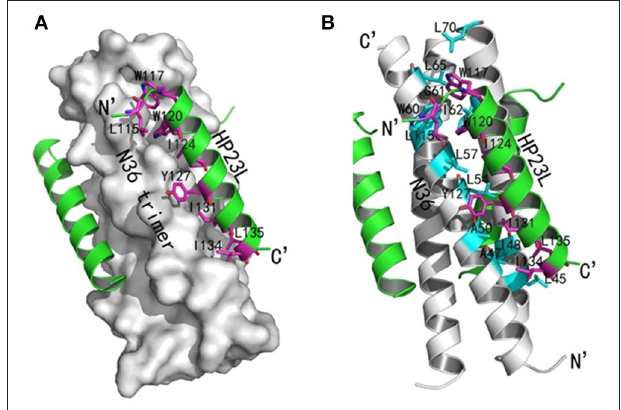
FIGURE 3 | Hydrophobic interactions in 6-HB structure of HP23L/N36. (A) The crystal structure of HP23L/N36 is presented in ribbon and surface models vertically by PyMOL. The N36 trimer is shown as surface model and colored in gray. The HP23L inhibitors are shown as ribbon models and colored in green. Residues related to hydrophobic interactions with N36 trimer on HP23L are shown as stick models in pink. The N- and C-termini of HP23L are labeled. (B) The crystal structure of HP23L/N36 is presented in ribbon models vertically by PyMOL. The N36 trimer is shown in gray. Residues related to hydrophobic interactions on N36 trimer are shown as stick models and colored in cyan. HP23L inhibitors are colored in green. Residues related to hydrophobic interactions with N36 trimer on HP23L are shown as stick models in